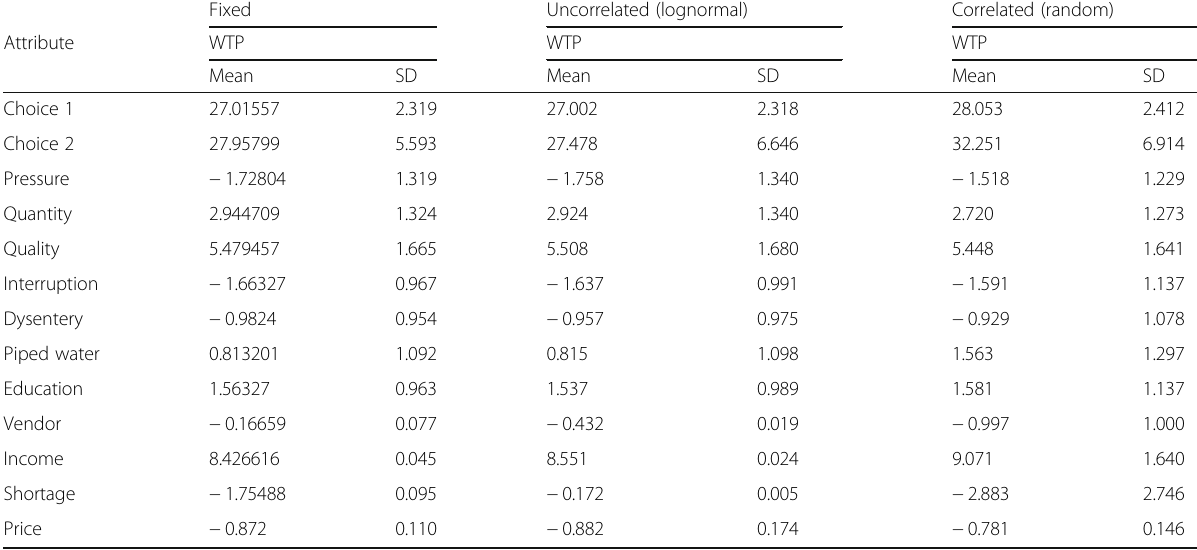
Table 6 Estimated coefficients (means and standard deviations) of the three models in the WTP space Fixed Uncorrelated